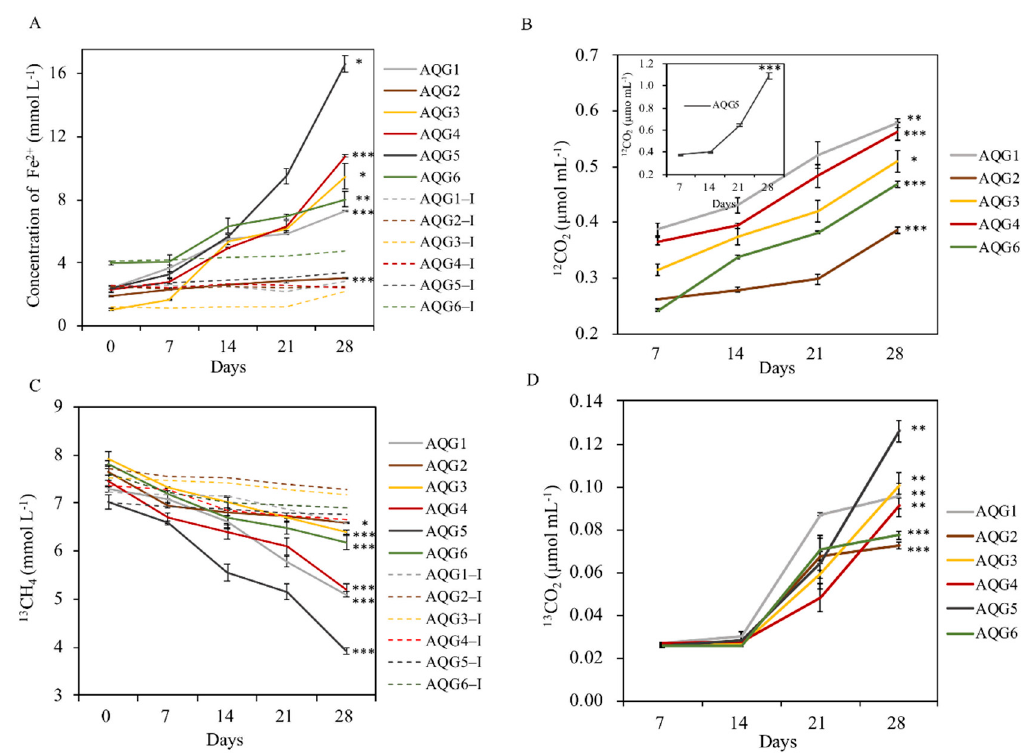
Figure 5. ( A ) Ferrozine-extractable Fe (II) in enrichments. ( B , D ) The production of 12 CO 2 and 13 CO 2 . ( C ) Anaerobic oxidation of 13 CH 4 . The dotted line represents the heat-inactivated control group. Error bars represent one standard deviation of the mean ( n = 3). The asterisk represents the significance of the t -test results between the 28 day and the initial data (0 day in Figure 5A,C, 7 day in Figure 5B,D) in experimental group (*** p < 0.001, ** p < 0.01, * p < 0.05).